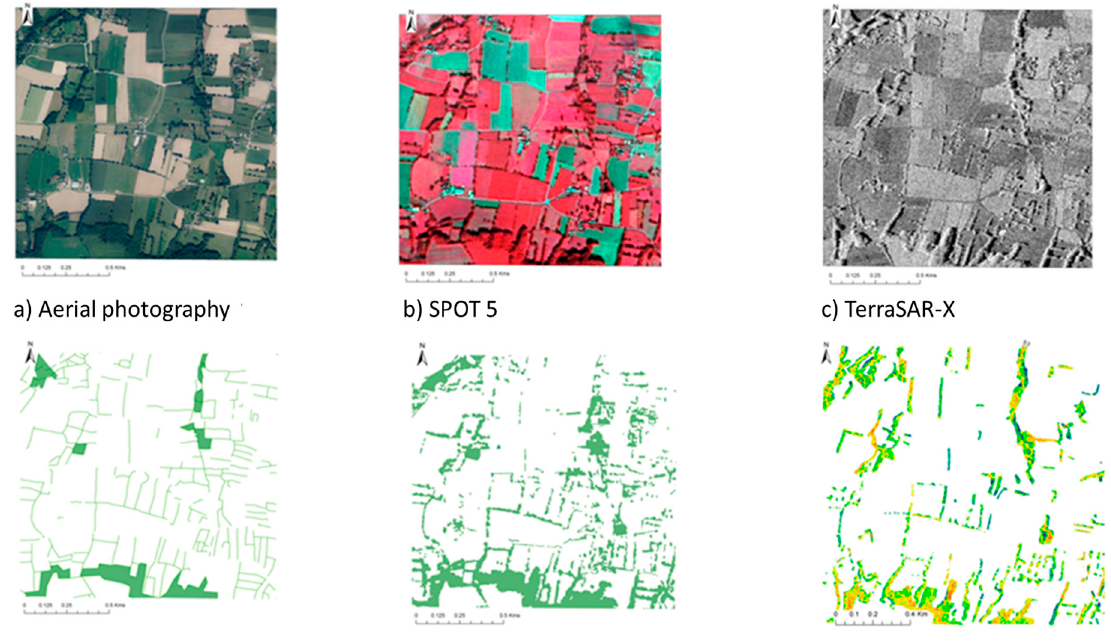
Figure 6. Hedgerow map classifications from an aerial photography ( a ), a SPOT 5 image ( b ), and a TerraSAR-X image ( c ). Figure obtained from Betbeder et al. [206].